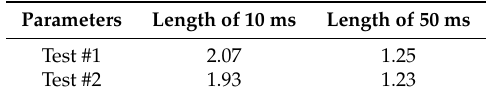
Table 4. CV values of instantaneous skewness for different time sections.